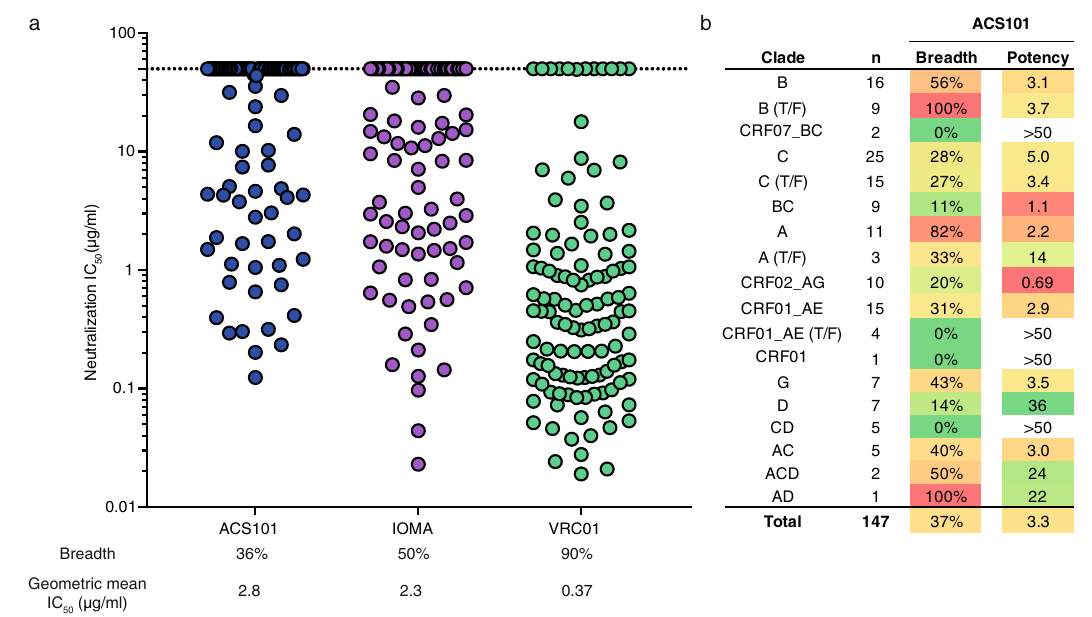
Fig.2| ACS101neutralizationbreadthandpotencyisinferiortothoseofIOMA andVRC01. Breadthisindicatedasthepercentageofvirusesthatwereneutralized. a NeutralizationIC 50 pro fi leofACS101,IOMAandVRC01againstapanelof( n =119) Tier-2 viruses. Each symbol represents a unique HIV-1 isolate. Data for IOMA and